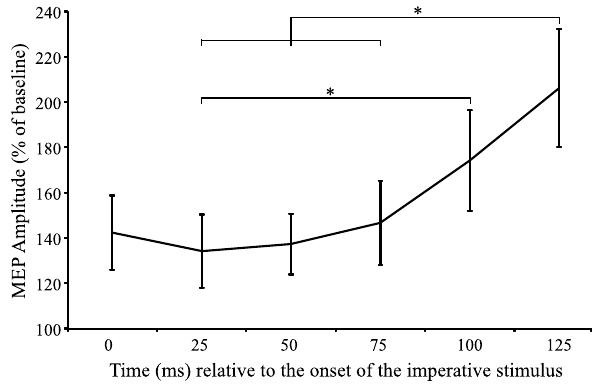
Figure 5. Mean ( + / 2 SE) motor-evoked potential (MEP) amplitude expressed as a percentage of baseline for the time encompassing 0 ms to + 125 ms relative to the onset of the imperative stimulus. Asterisks (*) denote significant differences in MEP amplitude during the initiation phase.